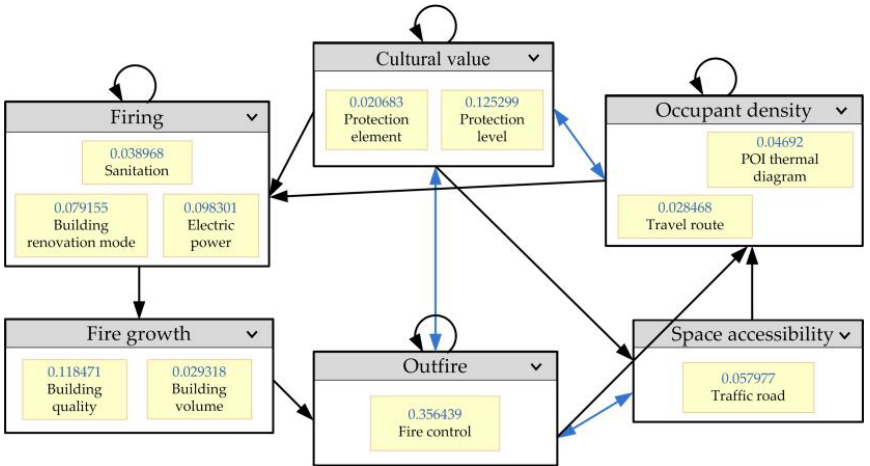
Figure 9. Yaahp-ANP network analytic hierarchy model weight calculation result. Table 5. Fire risk assessment index